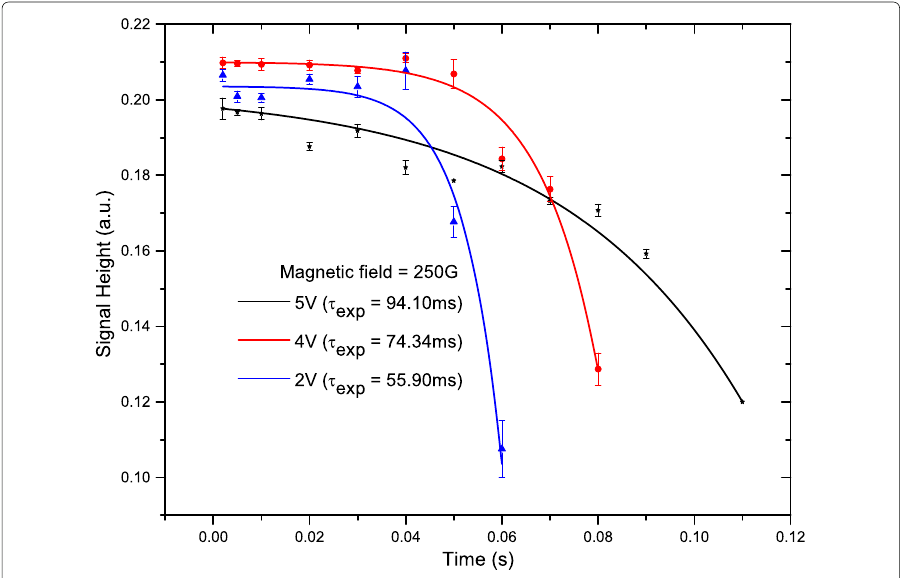
Fig. 7 Electron signal fall off with scanning time at step up voltages of 5V, 4V and 2V yielding different confinement